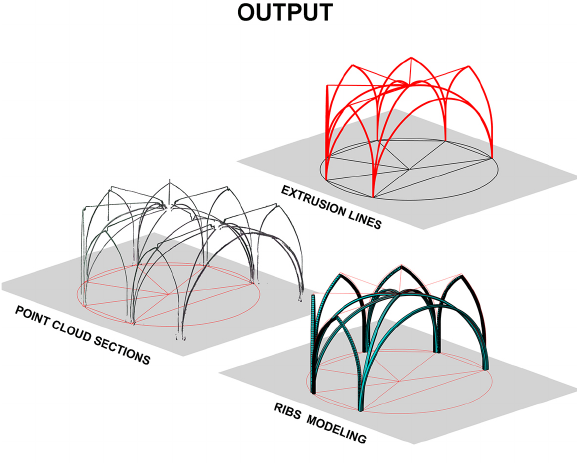
Figure 15 . Church of S. Lorenzo apses vault: compare between reality based model and ideal model